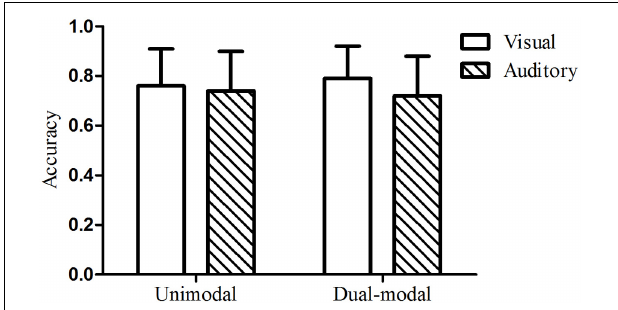
FIGURE 7 | Mean test accuracy under dual-grammar, dual-modality conditions (Experiment 3) compared to their corresponding unimodal baseline condition. The error bars represented the standard deviation of the mean to the